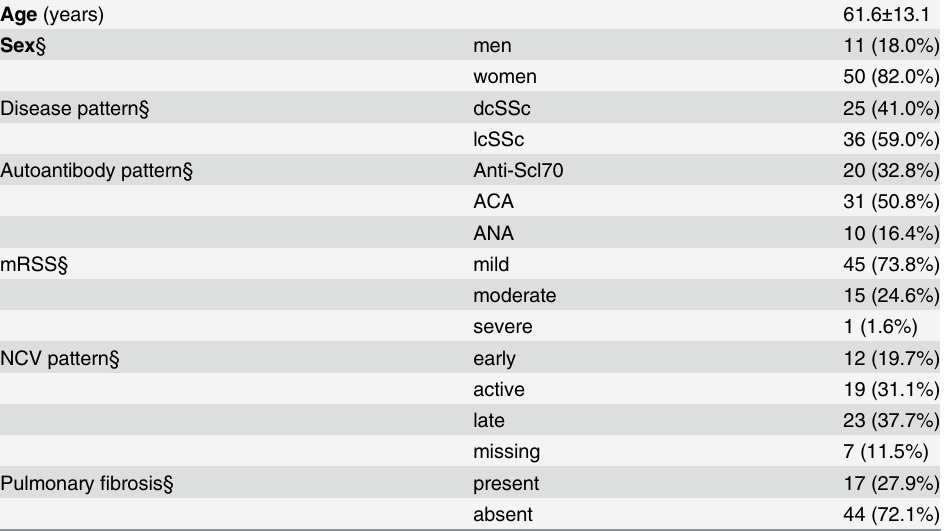
Table 1. Clinical data of SSc